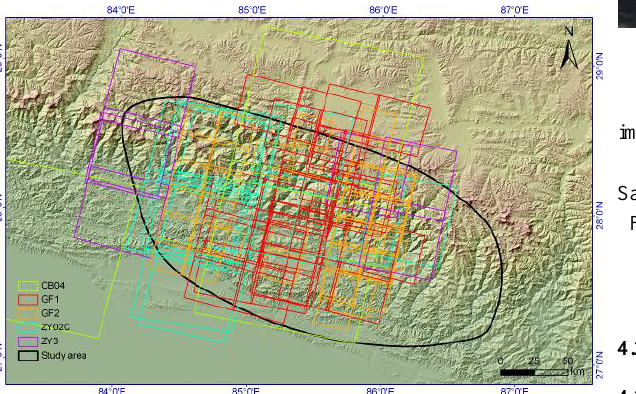
Figure 2. Coverage of pre-earthquake satellite images by China